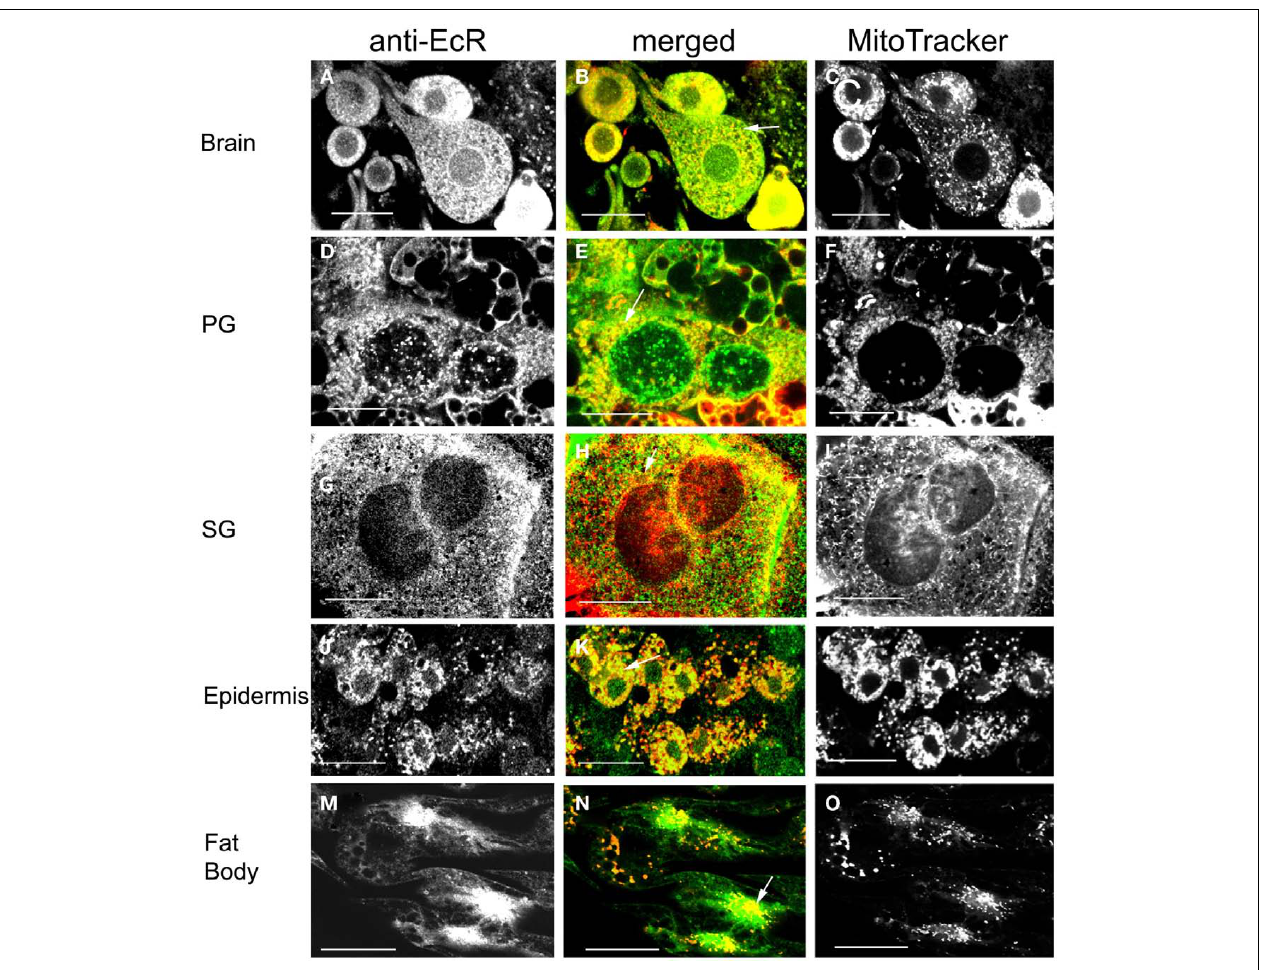
(A–C) , PG cells (D–F) , SG cells (G–I) , epidermal cells (J–L) , and fat body cells (M–O) . Arrows in the merged images (B,E,H,K,N) show co-localization as yellow dots. Scale bars = 10 μ